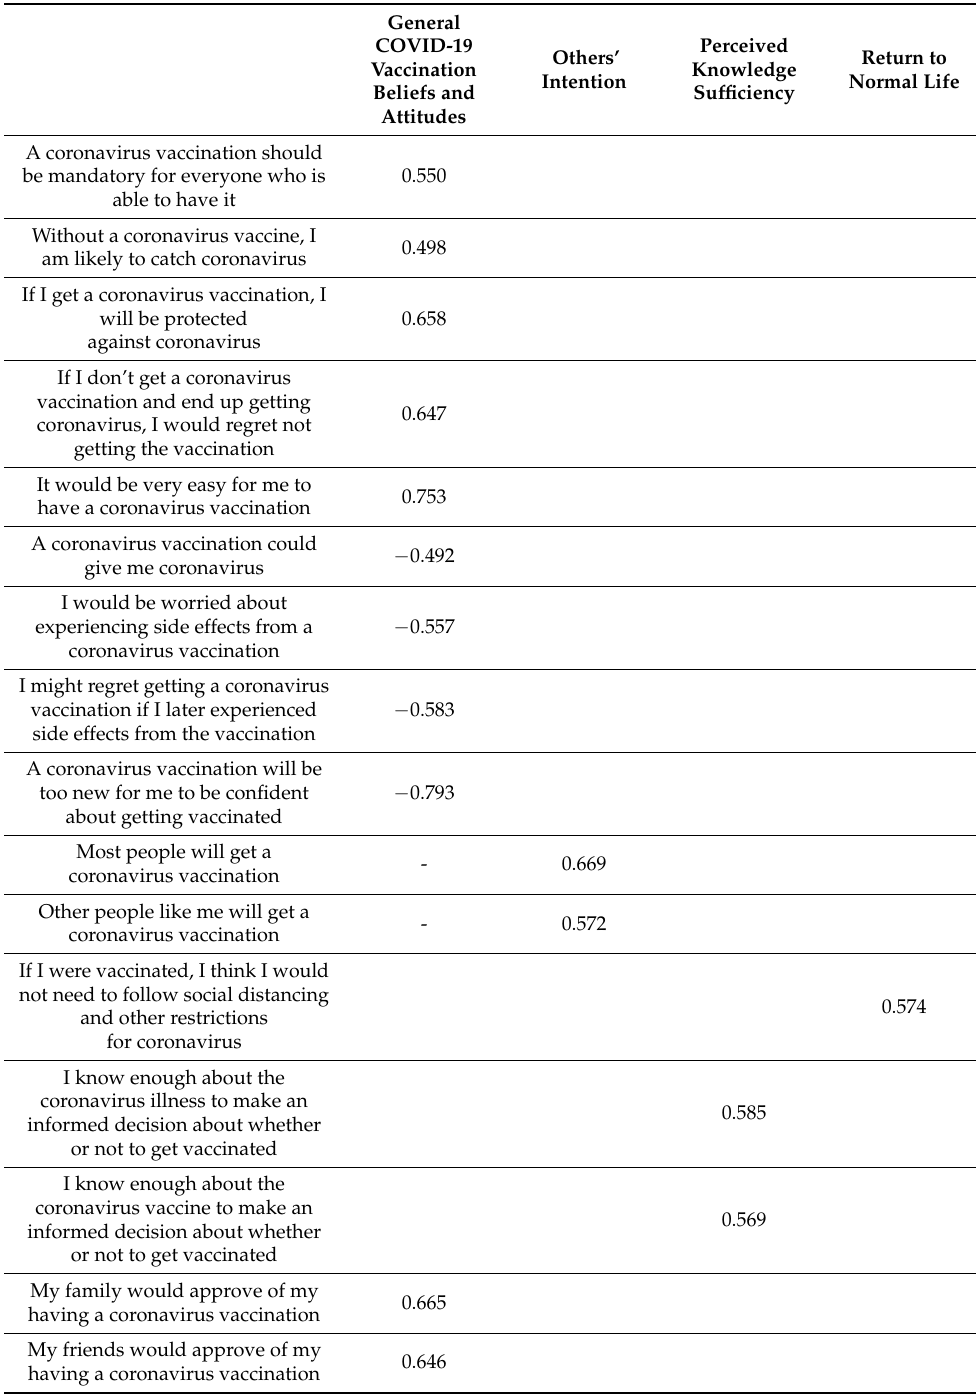
Table A3. Principal component loadings, following varimax rotation for items relating to attitudes and beliefs about the COVID-19